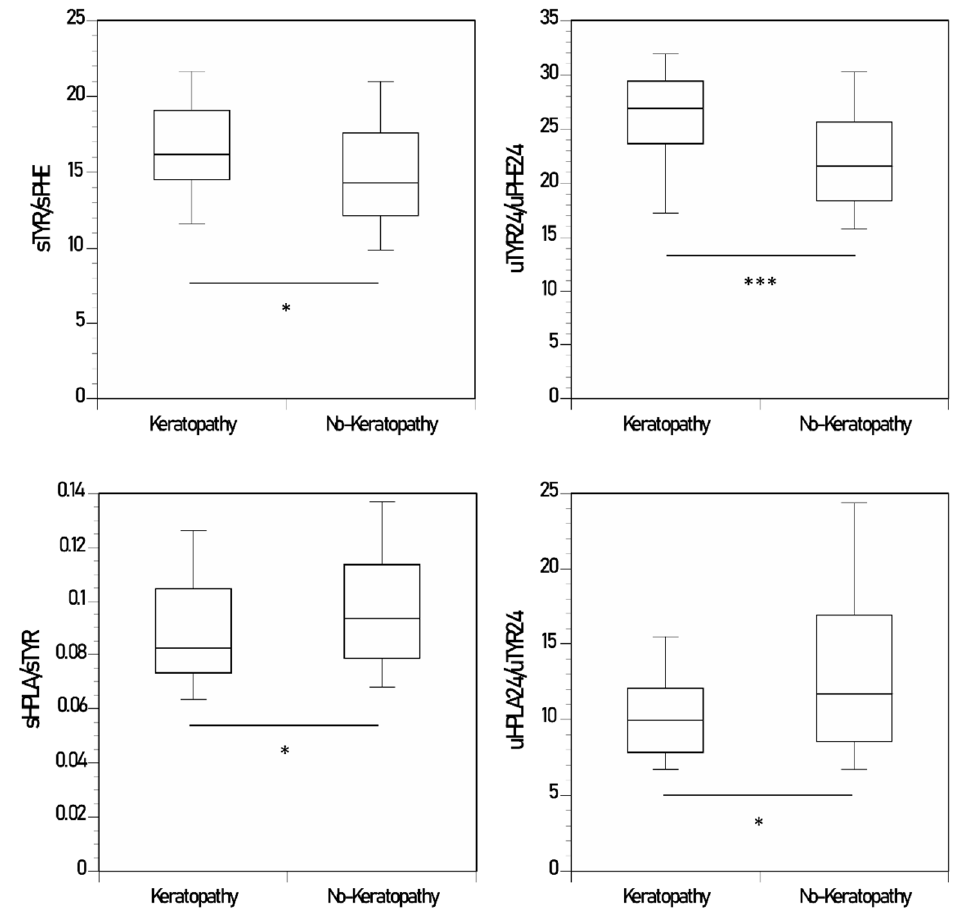
Figure 2. Changes in sTYR/sPHE & uTYR 24 /uPHE 24 , and sHPLA/sTYR & uHPLA 24 /uTYR 24 in the nitisinone group of the SONIA 2. ( p -values indicated for comparison between keratopathy and no- keratopathy sampling points where statistical significance was achieved; keratopathy sampling points n = 35; no-keratopathy sampling points n = 272 (data shown as boxplots with median) (statistical significance p expressed * < 0.05, ** < 0.01 and *** < 0.001, respectively).